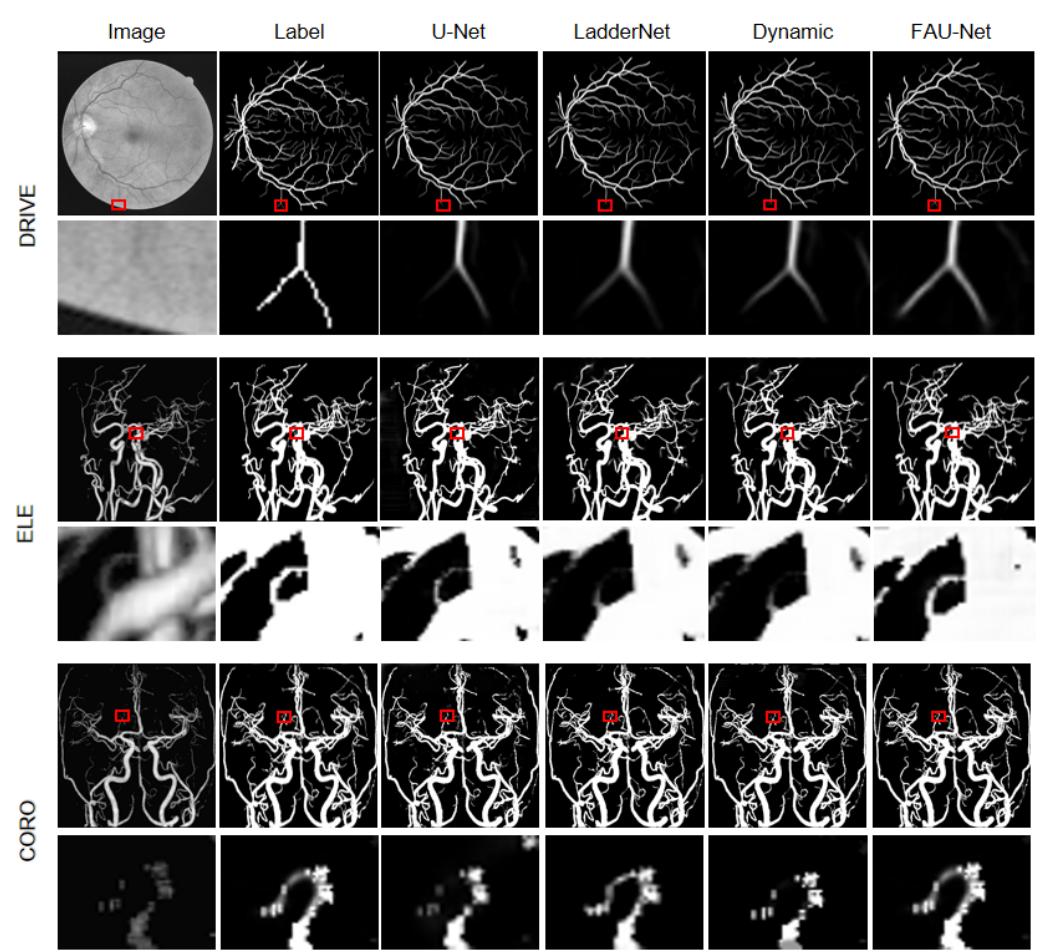
Figure 6. Visualization of the segmentation results on DRIVE, ELE, and CORO